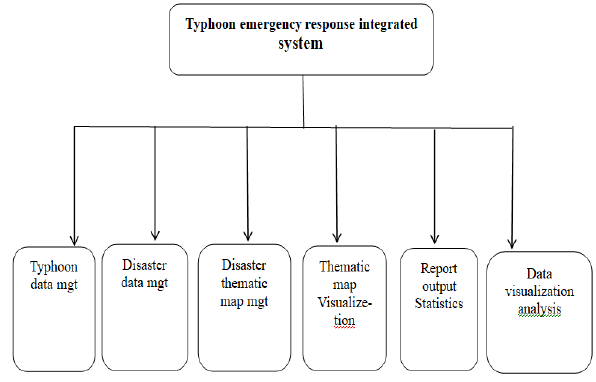
Figure2. The functional module diagrams of the system (1)Typhoon data management:Obtaining the typhoon information data (the typhoon occurrence time, the latitude and longitude, the typhoon location, the typhoon’s route path, the typhoon wind power and wind speed or other information) to store in the PostgreSQL database over the years from 1945 to 2018.Combined the PostgreSQL database typhoon information data of the system ’ s backend with the geographical information,and according to the query conditions of the response to retrieve the each data in the database.And the development trend of kinds of typhoons is displayed in the form of a line graph or a chart. Figure 1.The system ’ s overall architecture (2)Disaster thematic map management: According to the centimeter-level aerial images after the typhoon disaster